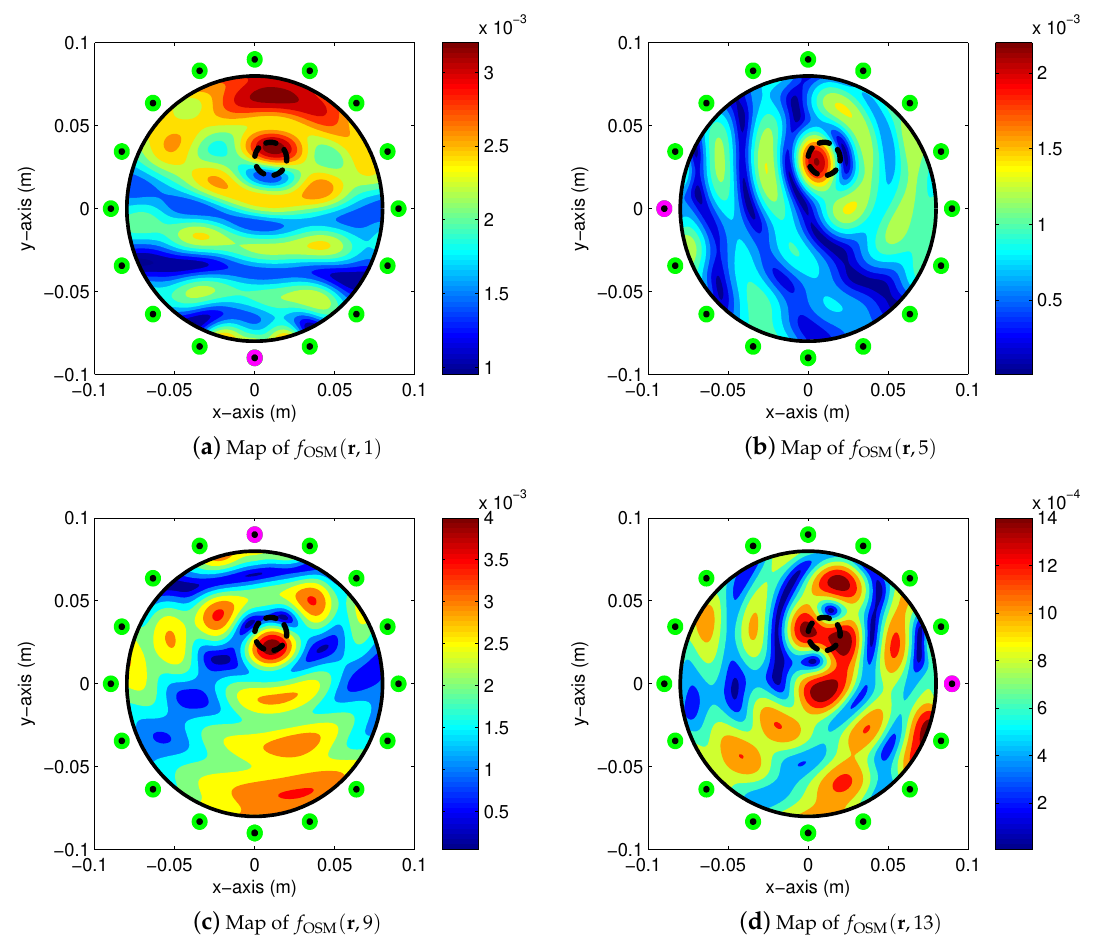
Figure 2. (Example 1) Maps of f OSM ( r , m ) . The black-colored dashed circle describes the anomaly